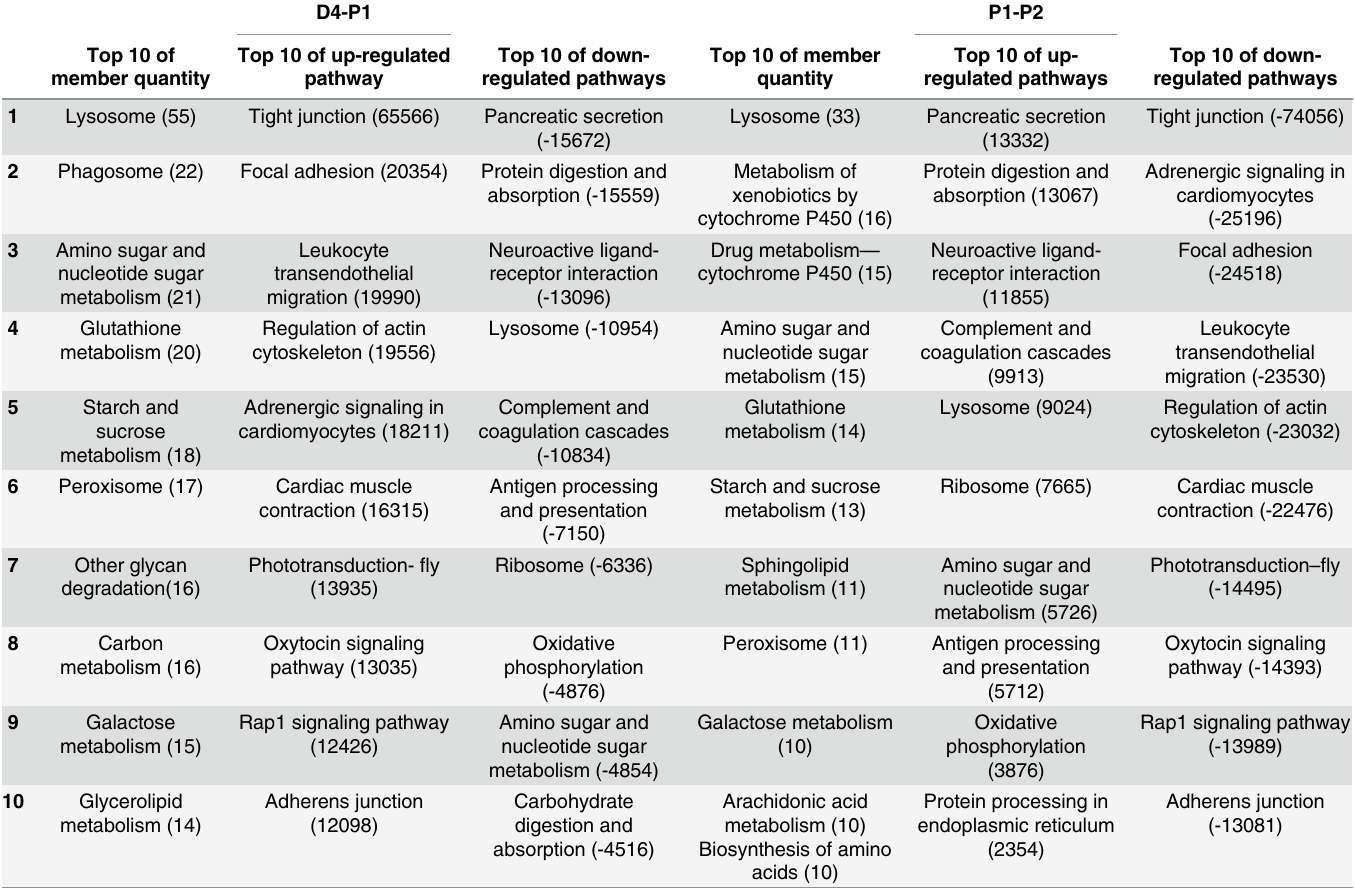
The top 10 up-regulating pathways and top 10 down-regulating pathways were identi fi ed by subtracting the fragments per kilobase of exon per million fragments mapped (FPKM) of D4 from P1 (P1 − D4) and P1 from P2 (P2 − P1). Digits in brackets indicate the number of differentially expressed genes (DEGs) and conversion of